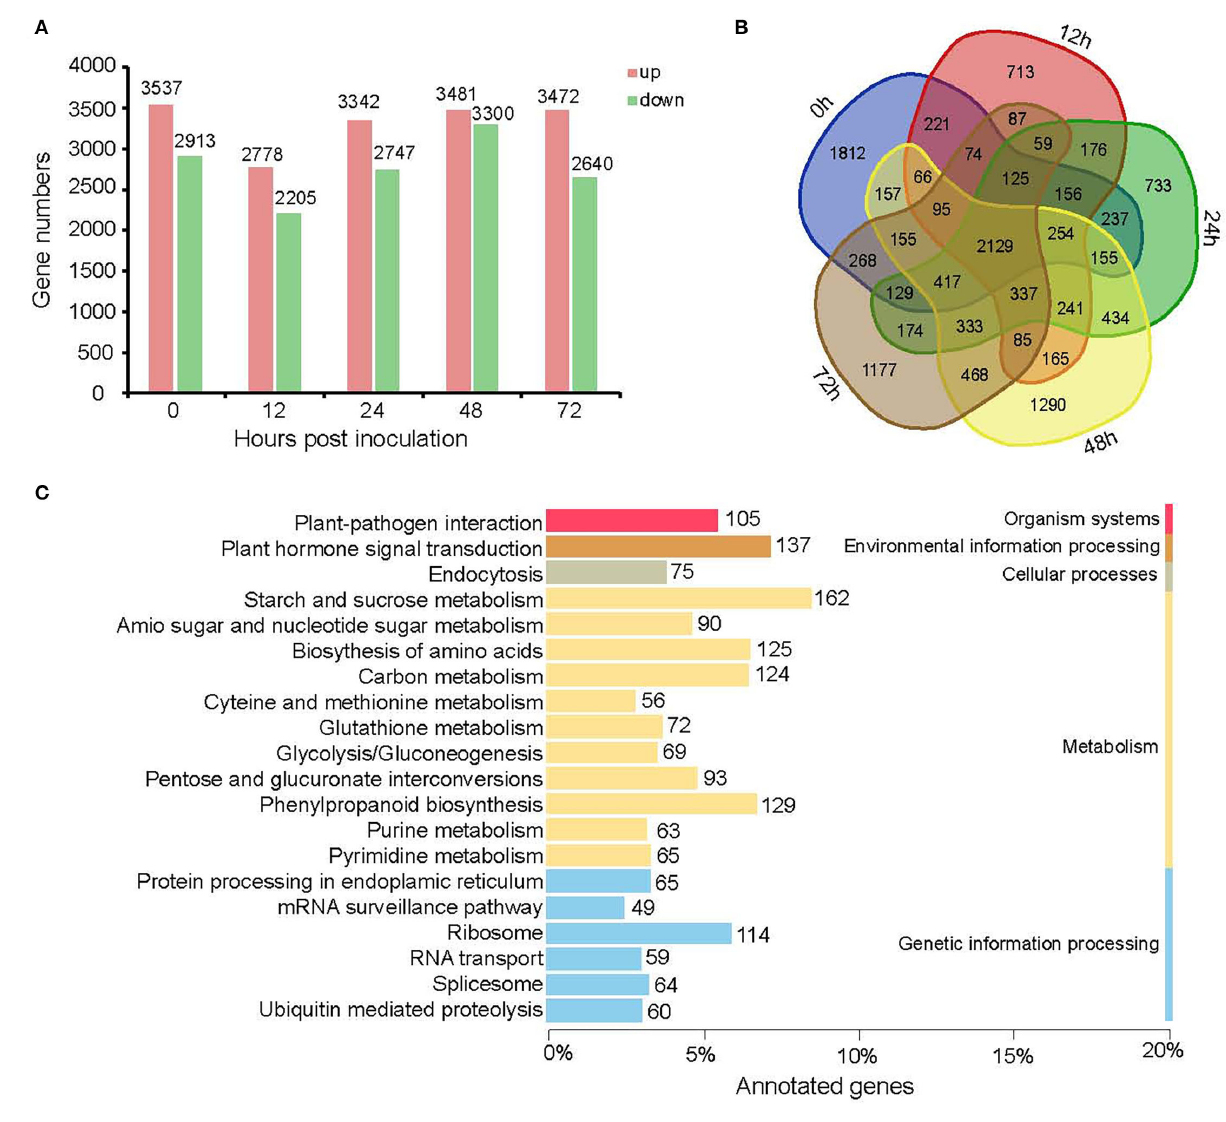
FIGURE 5 | Differential gene expressions in Y as compared with H at different time points. (A) The column chart shows the number of up-regulated (light coral bars) and down-regulated (spring green bars) genes at each time point. (B) Venn diagrams showing the common and specific DEGs for five time points. (C) The top 20 enriched KEGG pathways of DEGs between Y and H for five time